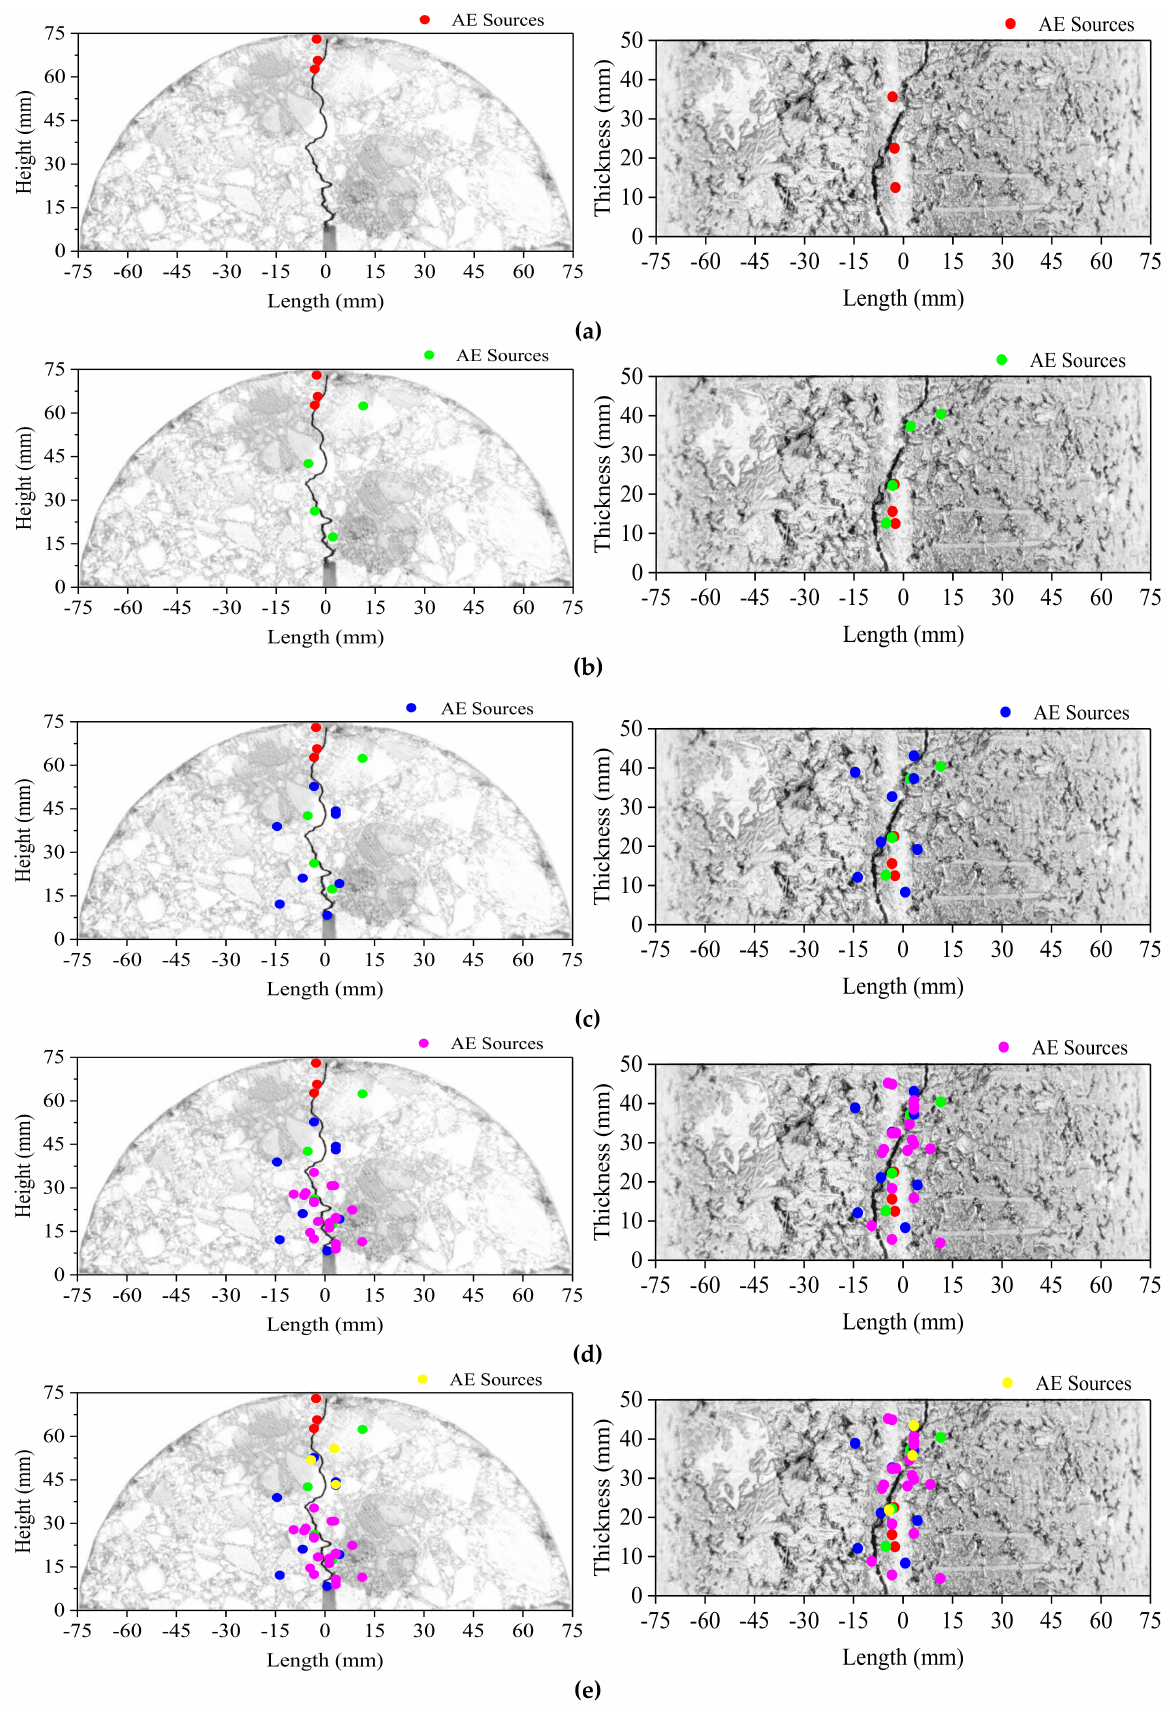
Figure 10. Location of AE sources at each period. ( a ) 0–10 s; ( b ) 10–15 s; ( c ) 15–20 s; ( d ) 20–22 s; ( e ) 22–25